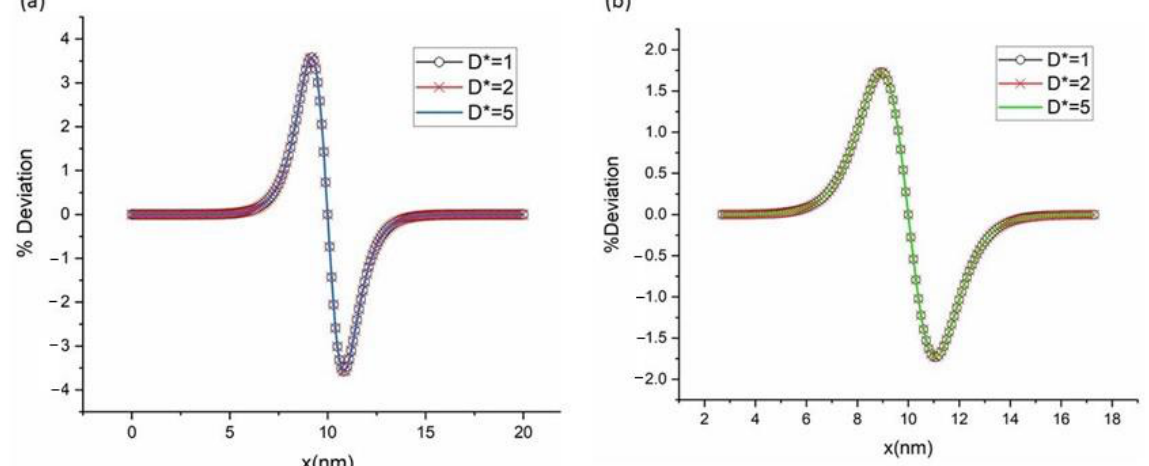
Figure 8. Deviation of solid composition along with the interface with dimensionless diffusivity 𝐷 ∗ = 1, 𝐷 ∗ = 2,and 𝐷 ∗ = 5 for ( a ) 𝛽 𝑆0 = 1; ( b ) 𝛽 𝑆0 = 2